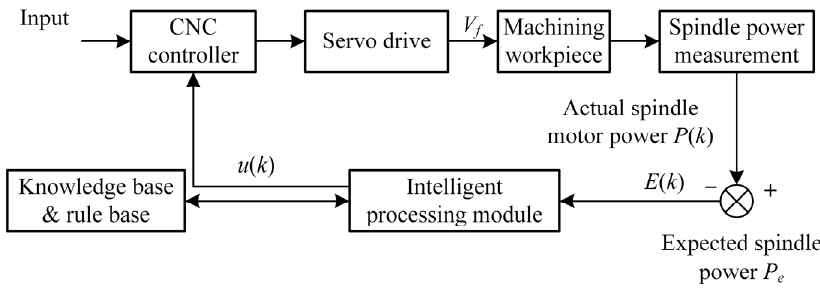
Figure 9. Scheme of intelligent compensation solution for feed rate.